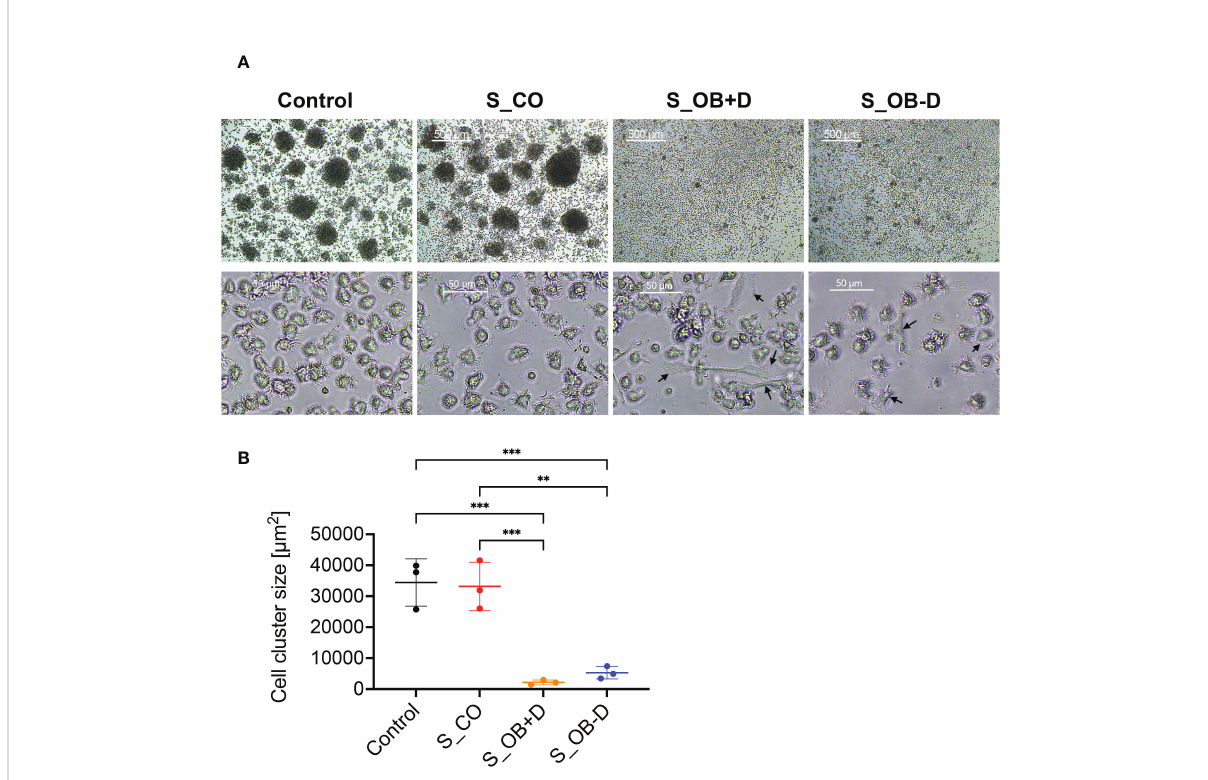
FIGURE 3 Effects of JPC secretomes on the homotypic cluster formation and the morphology of MoDCs. CD14 + monocytes were cultured with DC cocktails for 6 days (control). 5-fold concentrated secretomes of JPCs treated with control medium (S_CO), osteogenic medium with or without dexamethasone (S_OB+D/S_OB-D) were added to the DC induction cocktail respectively. (A) Representative microscopic images of three independent experiments (scale bars represent 500 and 50 µm respectively). Black arrows are pointing at adherent cells in non-round shape. (B) Quanti fi cation of cell cluster size using ImageJ. Results of three independent experiments are given as means ± SD and compared using one-way ANOVA followed by Tukey ’ s multiple comparisons tests (n=3, **p < 0.01, ***p <